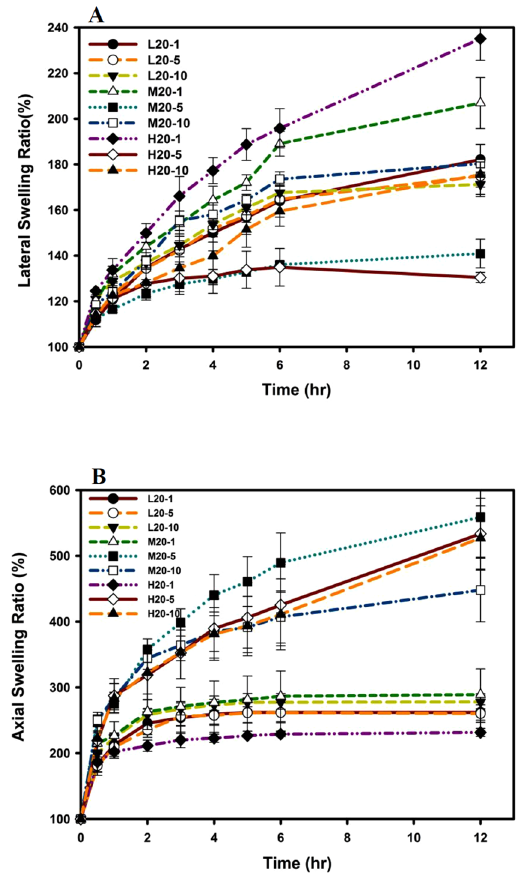
Figure 4. Lateral ( A ) and axial ( B ) swelling abilities of tablets prepared with ring-opened polyvinyl pyrrolidone ( ro PVP)/chitosan (CS) hydrogels composed of ro PVP complexed with either low molecular weight (Mw) CS (L), medium Mw CS (M), or high Mw CS (H) at three ro PVP:CS ratios of 20:1 (20-1), 20:5 (20-5), and 20:10 (20-10).